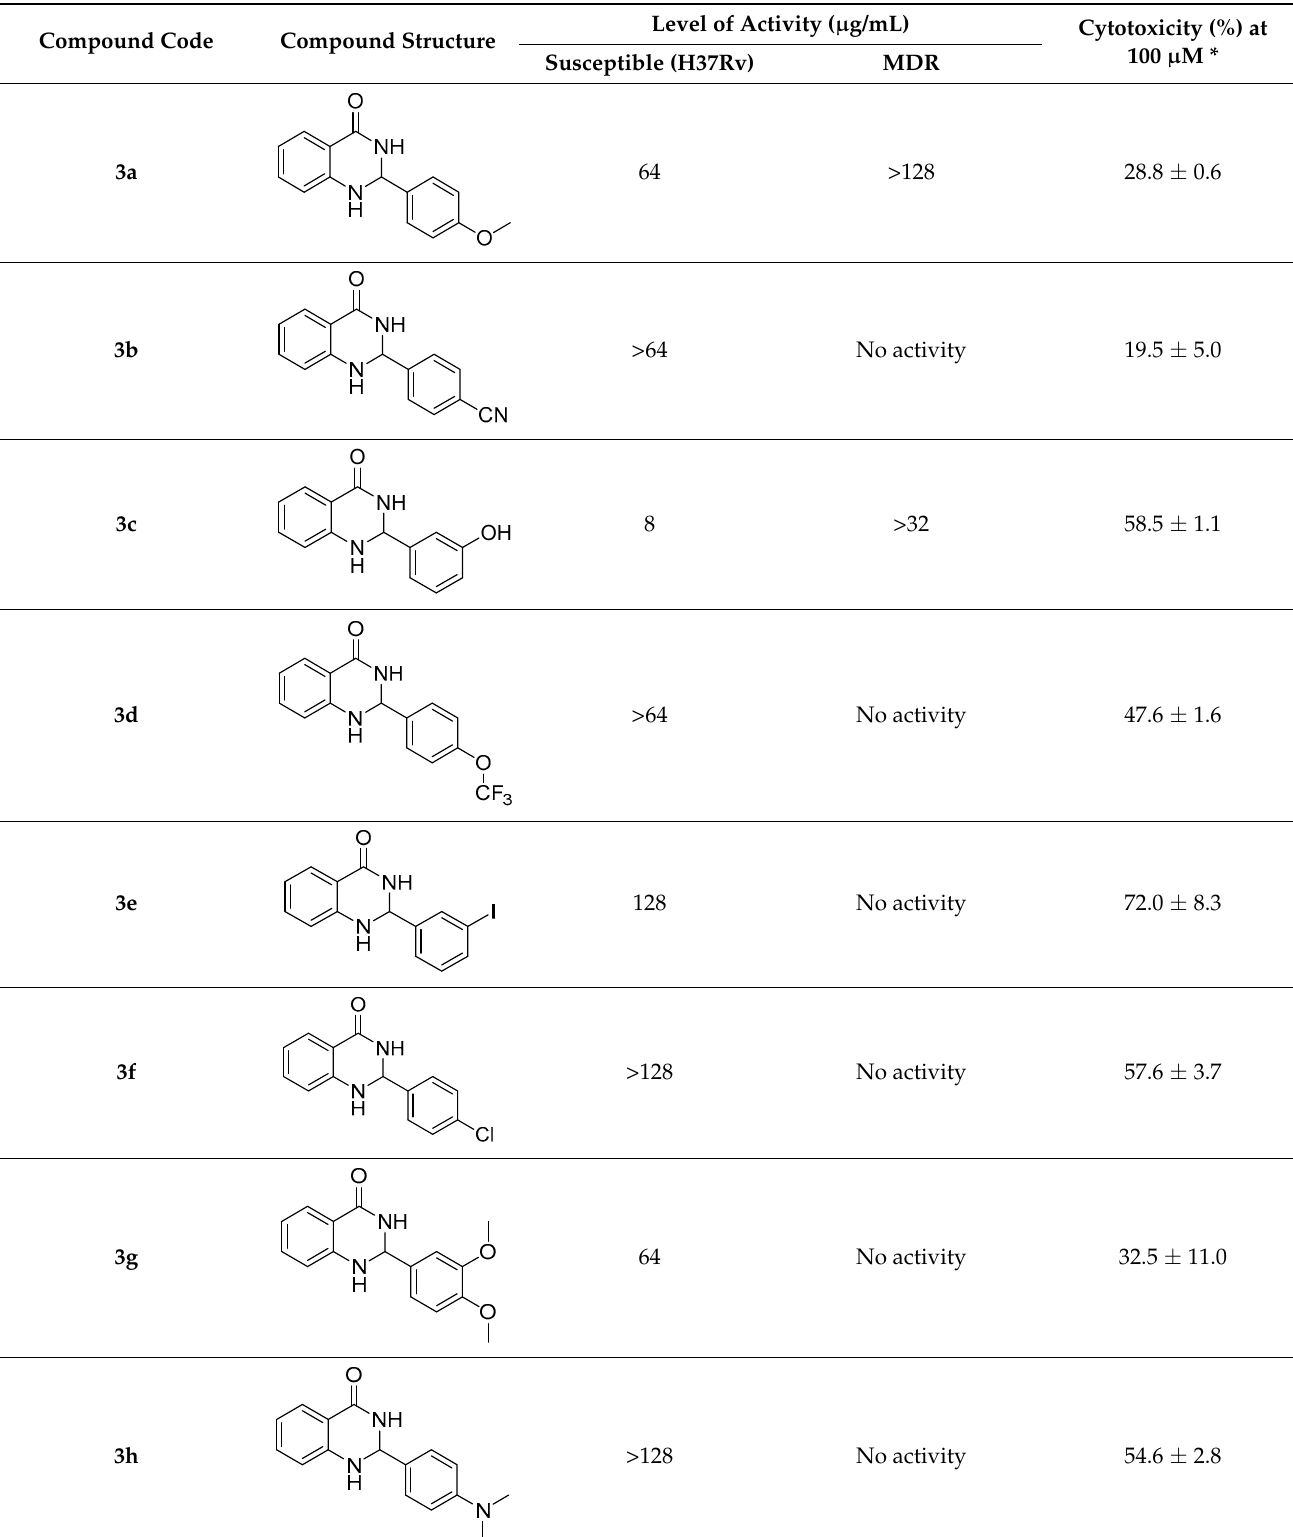
Table 1. In vitro whole-cell anti-TB results of substituted 2,3-dihydroquinazolin-4(1 H )-ones analogues ( 3a – m ) against Mycobacterium tuberculosis and their cytotoxic effect on fibroblast cells.